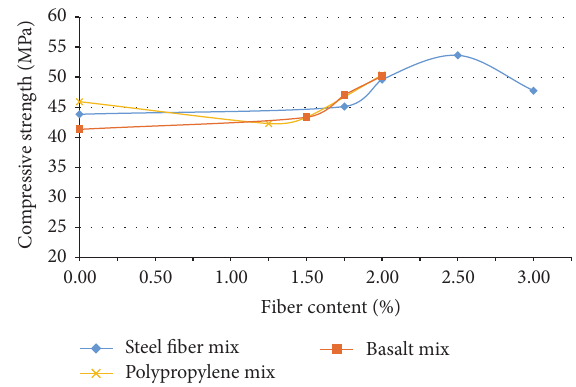
Figure 7: Comparison of compressive strengths with fiber mix at different